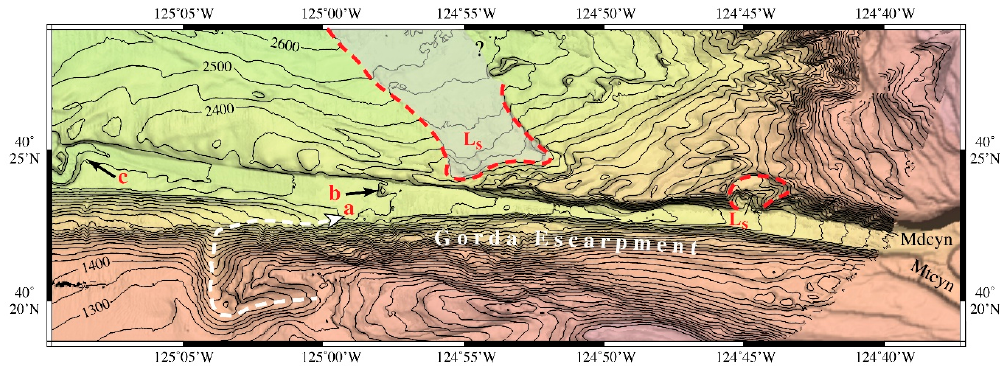
Figure 8. Map view of multibeam bathymetry of the upper straight reach (USR). Ten km black circles mark distances in km in italics from the junction of Mendocino and Mattole Canyons. White dashed arrow shows thalweg of upper side channel (see discussion below), red “a” is the point where the upper side channel enters the USR, red “b” is a large 60 m high mound on the floor of Mendocino Channel (see text) and red “c” is 90° channel bend. “Mdcyn” is lower Mendocino Canyon and “Mtcyn” is lower Mattole Canyon. Red dashed lines outline landslide scarps (Ls) with area of hummocky relief in gray. Isobath interval is 50 m, representative 100 m isobaths are labeled. Isobaths of Gorda Escarpment intentionally not labeled. See Figure 2 for location.